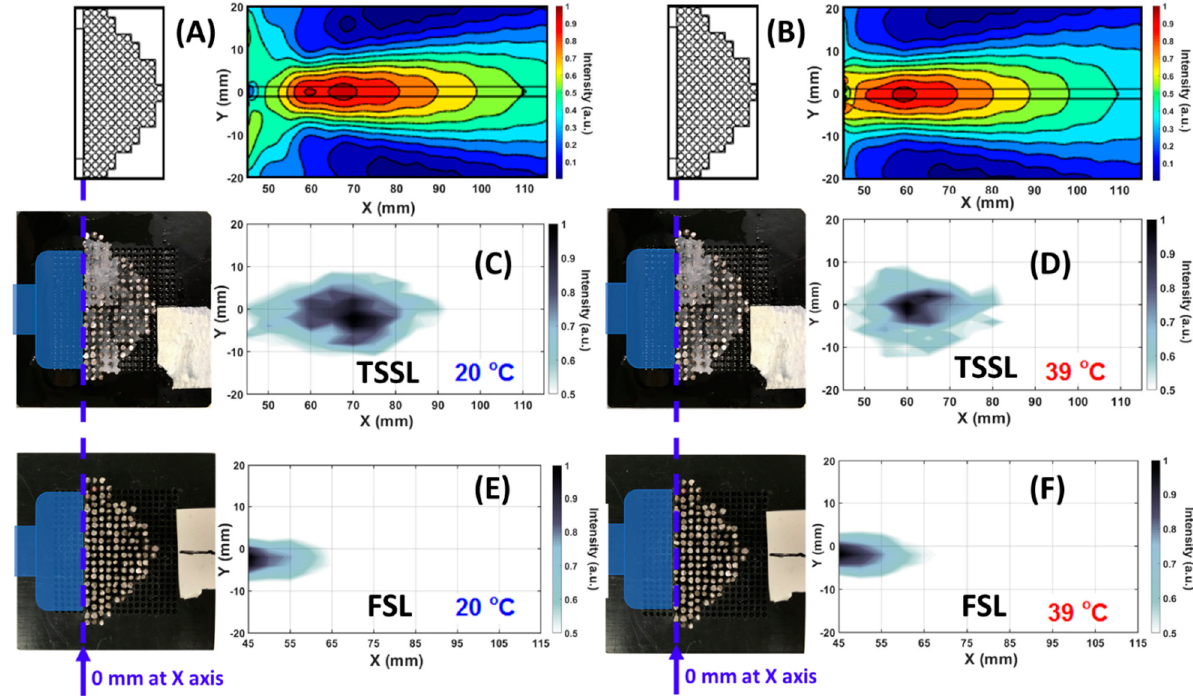
Figure 2. Sound intensity maps of TSSL (infilled with hydrogel) comparing with FSL (infilled with ambient water). Origin point of the X -axis in the contours was at the interface between transducer and lens. ( A , B ) illustrated numerical simulation of the focusing fields of TSSL at 20 °C and 39 °C. ( C ) Focusing point of TSSL at 20 ℃ . ( D ) Focusing point of TSSL at 39 °C. ( E ) Focusing point of FSL at 20 °C. ( F ) Focusing point of FSL at 39 °C.